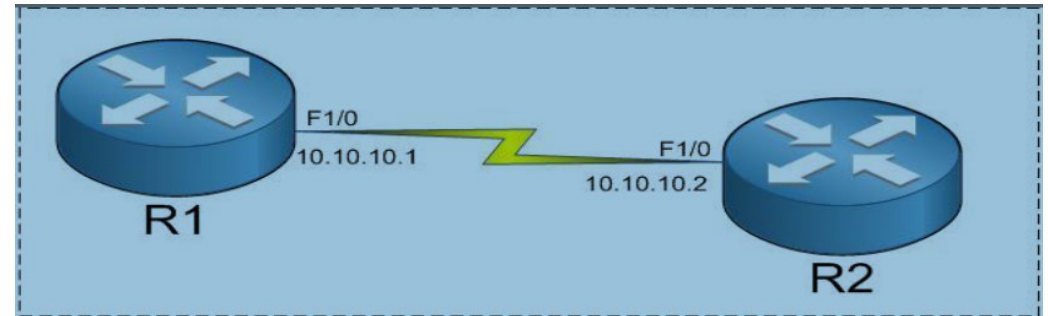
Figure 2.1. Site to the Site VPN router